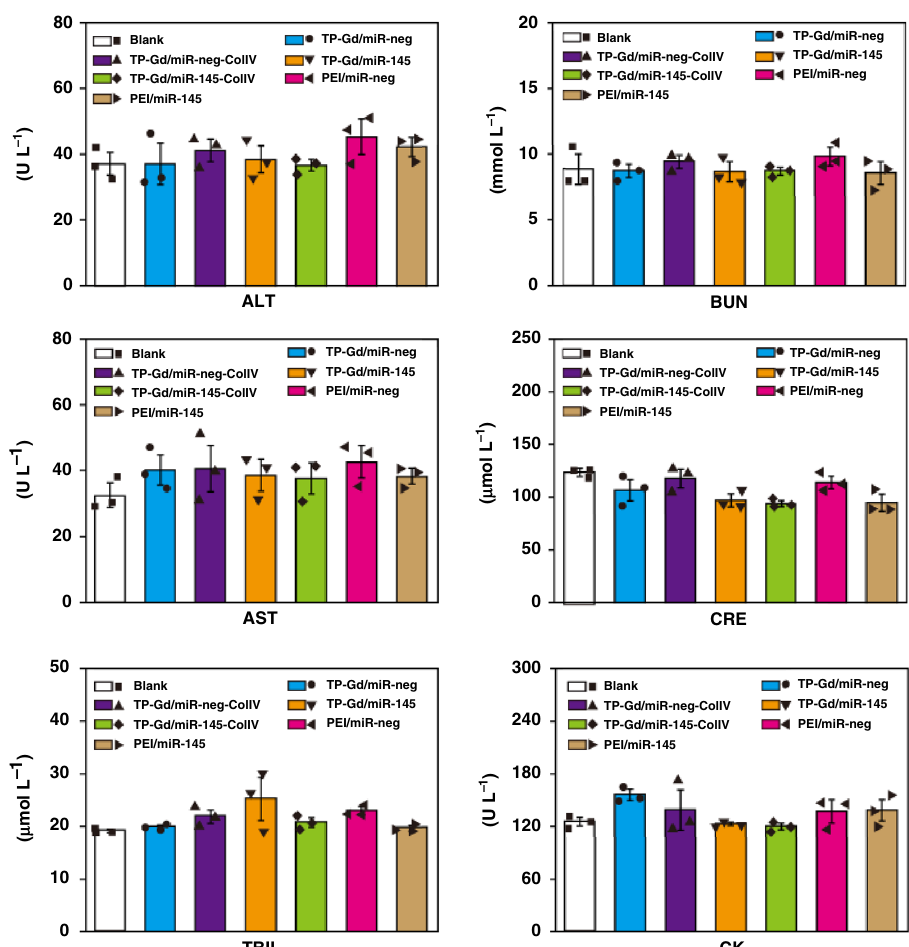
Fig. 9 Plasma biochemical measurements of aspartate transaminase (AST), alanine transaminase (ALT), total bilirubin (TBIL), blood urea nitrogen (BUN), creatinine (CRE), and creatine kinase (CK). ( n = 3 animals; error bars represent standard deviation; source data are provided as a Source Data fi